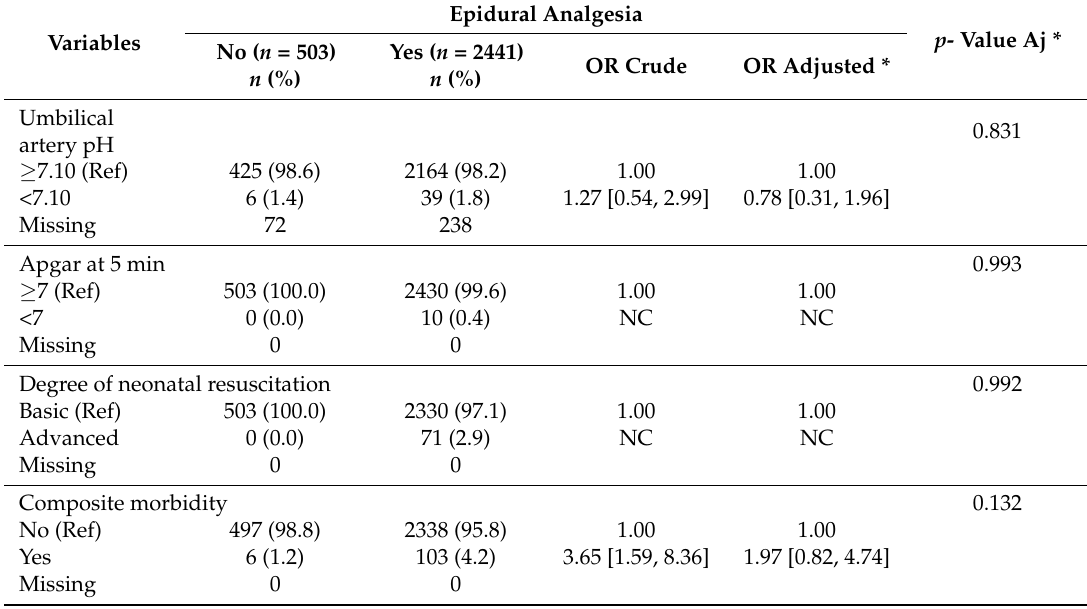
Table 2. Main key indicators of neonatal morbidity and its relation with the use of epidural analgesia in population